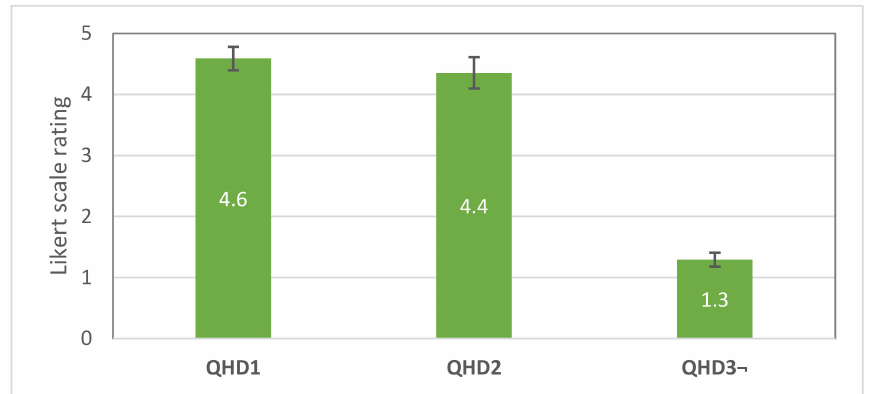
Figure 20. Average scores with standard errors for the questions QHD1–QHD3 used for evaluation of the usability of V3 interface. Score 5 denotes “totally agree”, and 1—“totally disagree”. Questions QHD1, QHD2—higher is better; QHD3—lower is